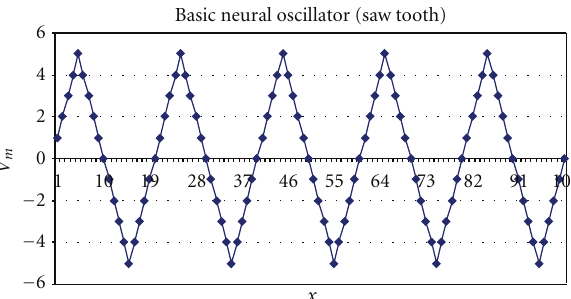
Figure 2: Output of a neural oscillator created by adding a constant ( C = 1) in the Exciter state and subtracting a constant ( C = 1) in the Inhibitor state.